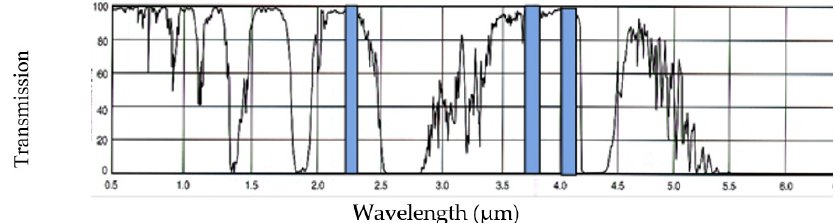
Figure 3. The CMIS bands (blue shaded) area superimposed on a MODTRAN atmospheric transmission spectrum. Notice that the SWIR band (2.25 μ m) and MWIR bands (3.75 and 4.05 μ m) are in high transmittance windows.